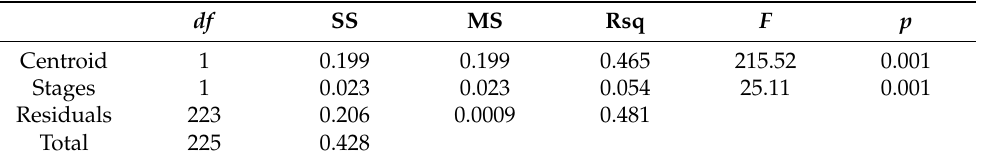
Table 1. ANOVA results to determine the effect of centroid size and ontogeny phase on the body shape of Chelon auratus